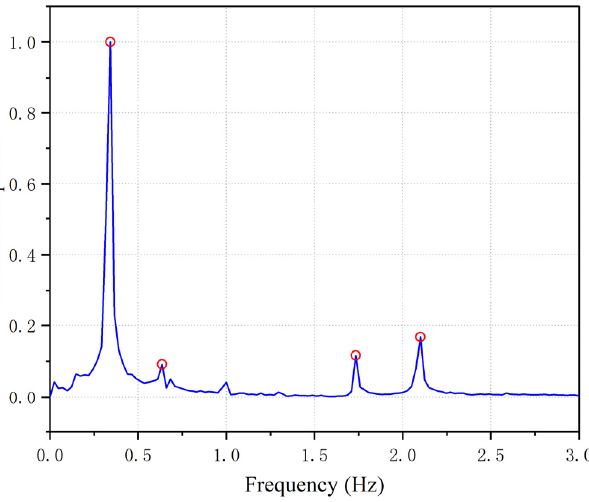
Figure 13. The results of practical data by FFT. The red circles indicate estimated